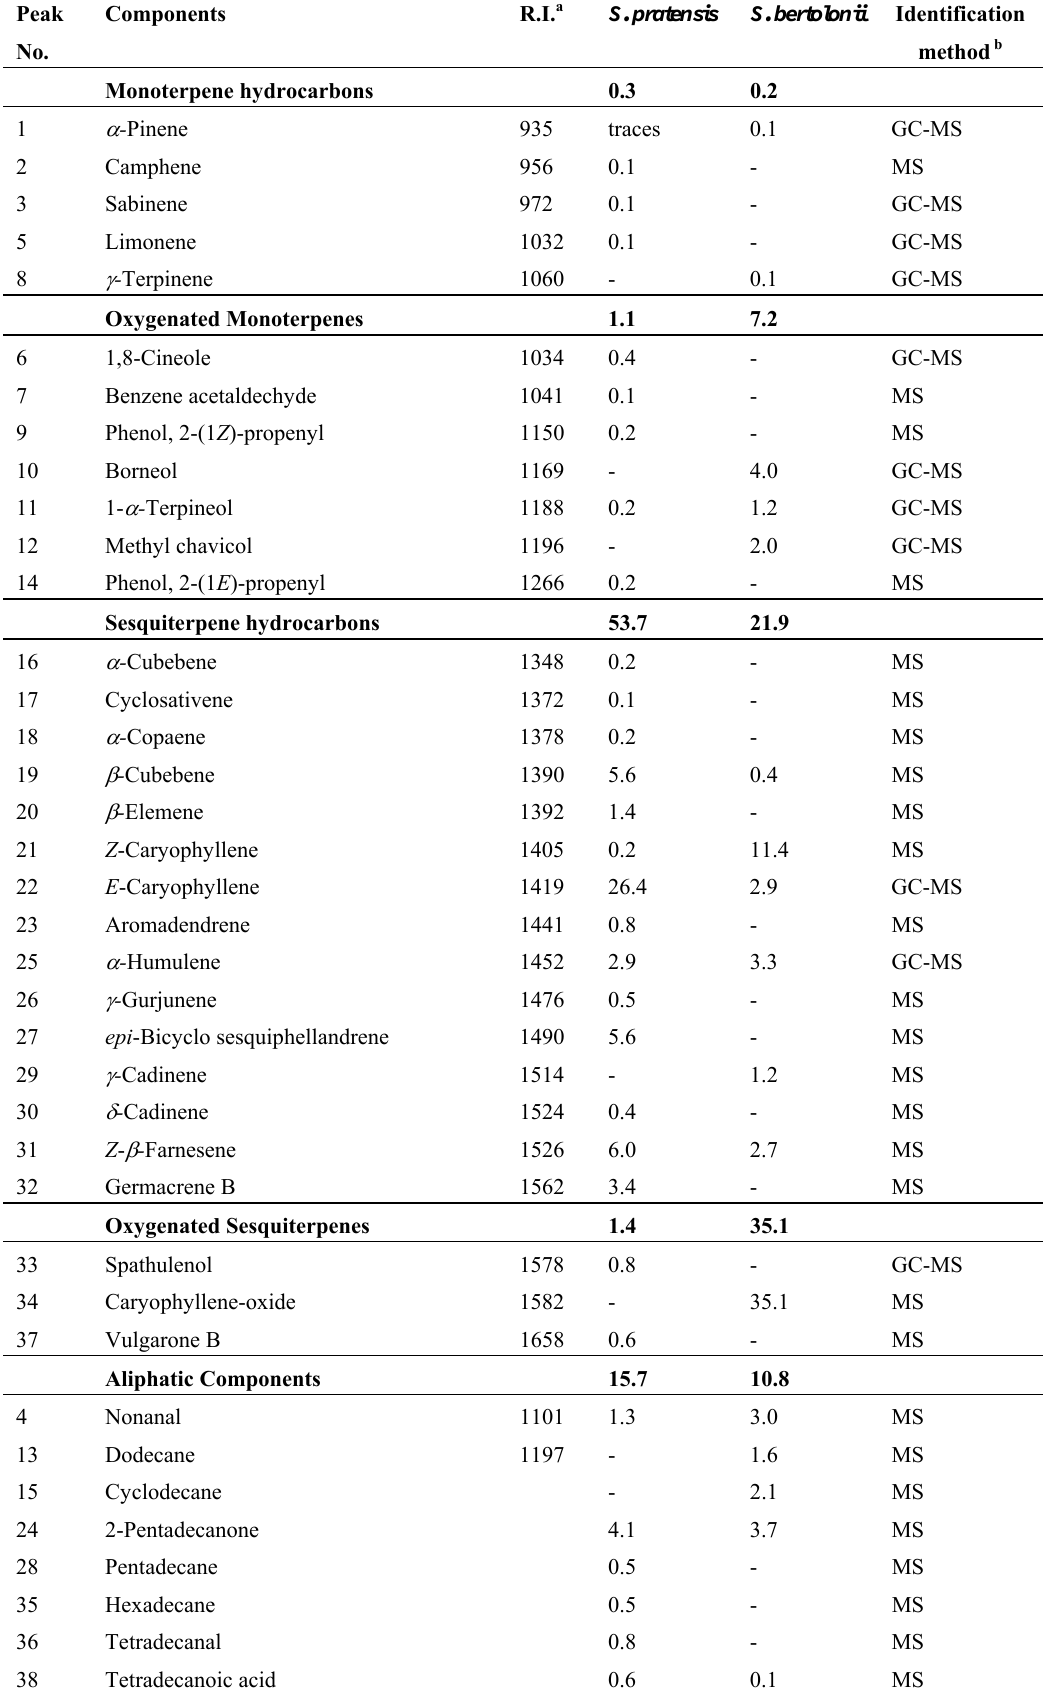
Table 1. Chemical composition (%) of essential oils of S. pratensis and S. bertolonii .